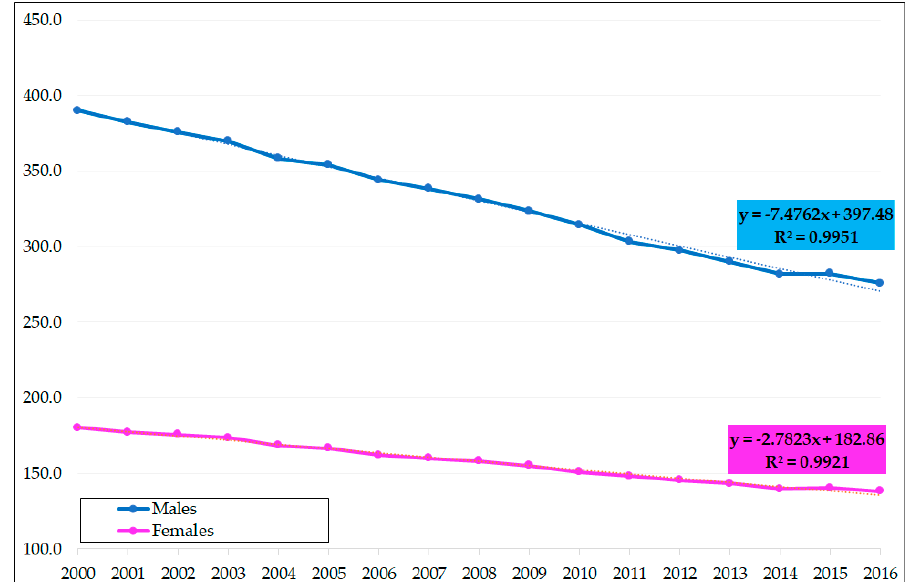
Figure 1. Premature standardized death rates (SDR) in 28 EU member countries (EU-28) for males and females including linear regression lines. Source: Own calculations based on Eurostat database [20].